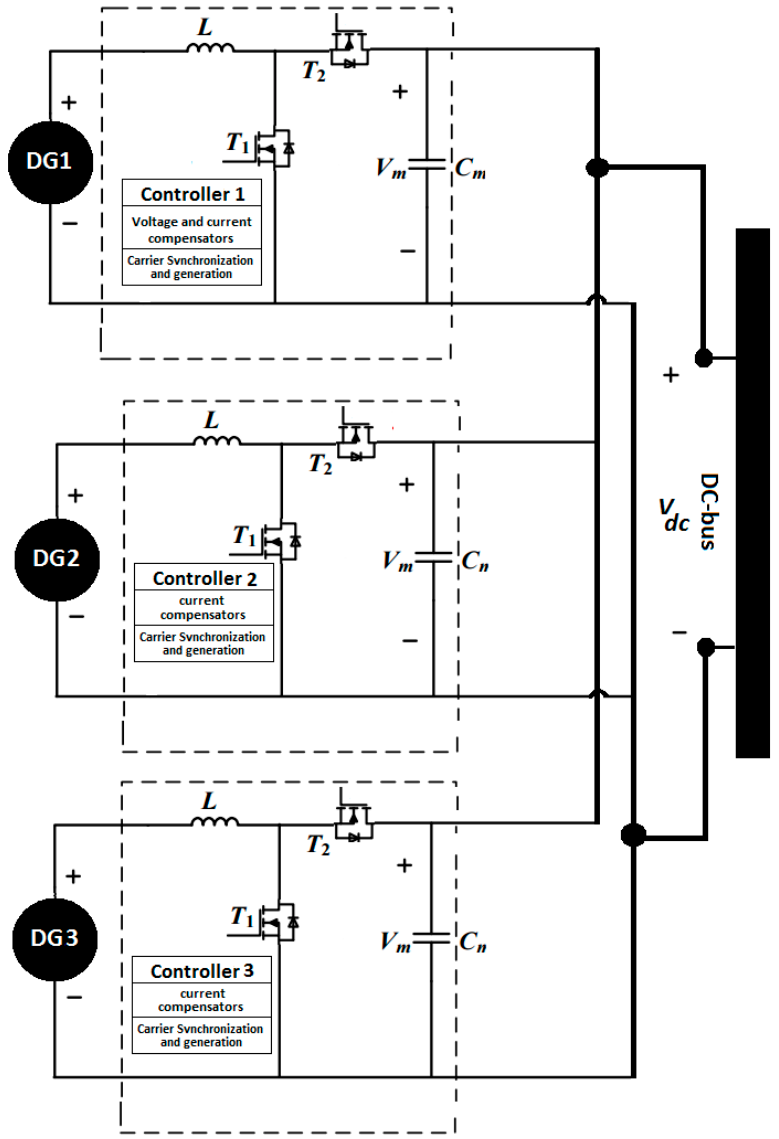
Figure 10. DC Microgrid power network. Table 1. DC power network parameters.